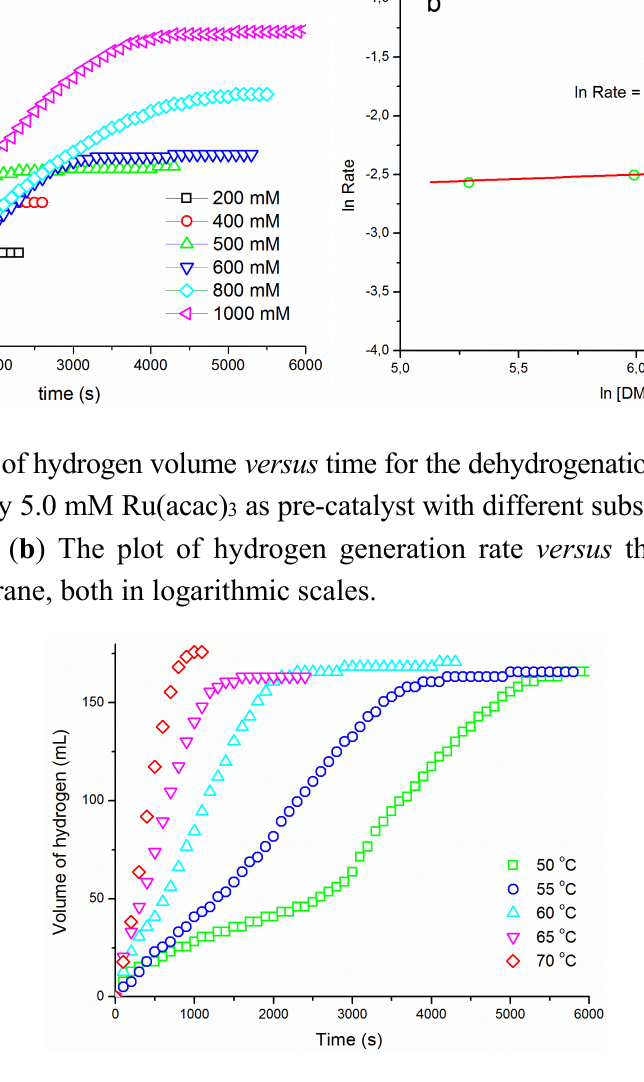
Figure 3. Plots of hydrogen volume versus time for dehydrogenation of dimethylamine borane starting with a solution containing 500 mM NH(CH 3 ) 2 BH 3 and 5.0 mM Ru(acac) 3 at various temperatures. Table 1. Values of the rate constant k in (mol H 2 )·(mol Ru) − 1 ·s − 1 for dehydrogenation of dimethylamine borane (500 mM) catalyzed by ruthenium(III) acetylacetonate (5.0 mM) at different